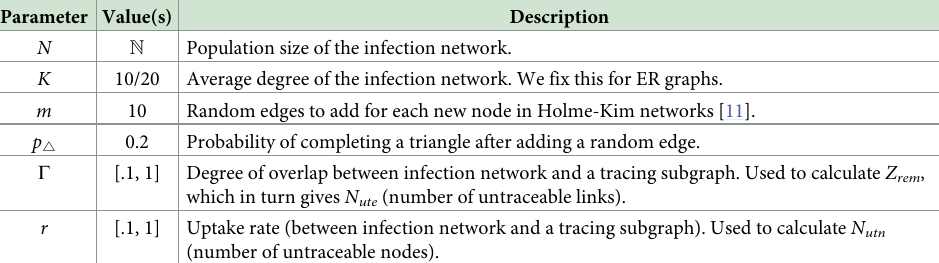
Table 2. Network-generation